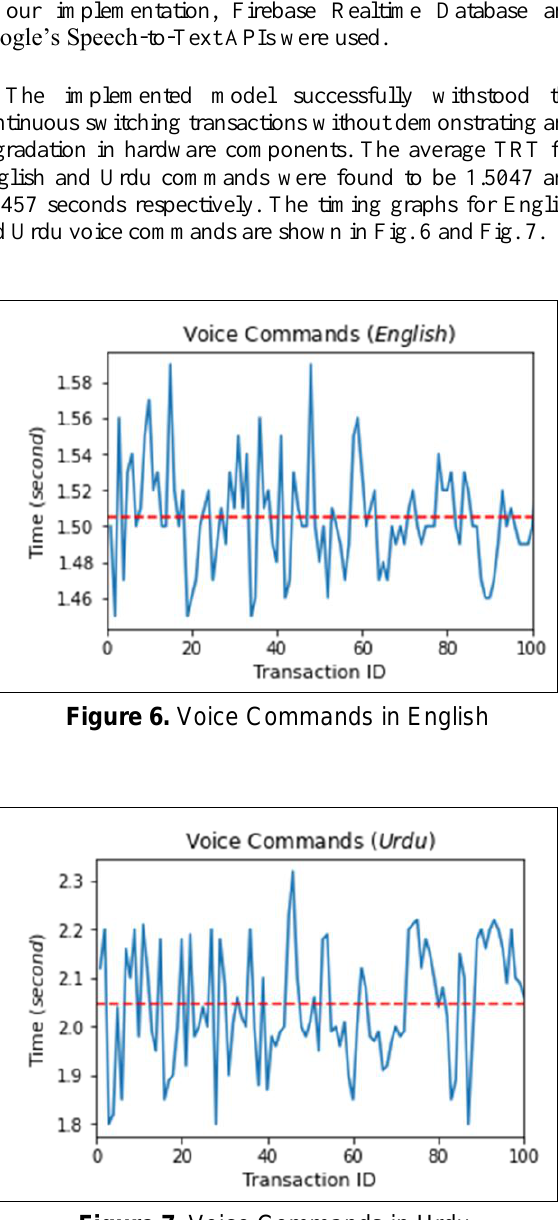
Figure 7. Voice Commands in